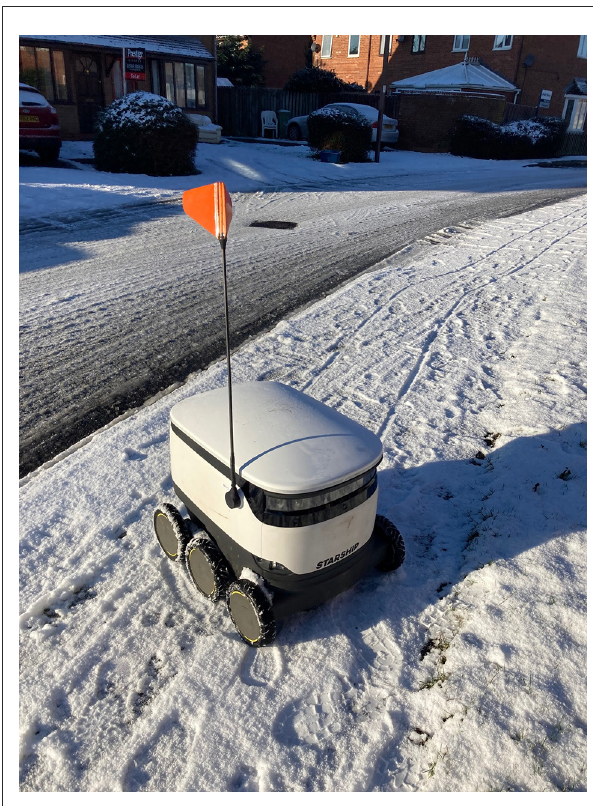
adapted may allow them to support key urban functions when